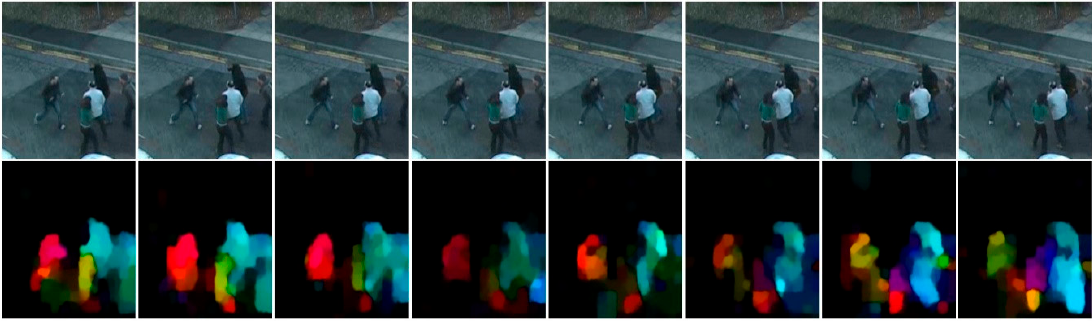
Figure 3. Optical flow on a violent sequence. First line contains eight frames from a fight sequence. The second line contains the corresponding color-coded MPEG flow feature maps (rescaled).